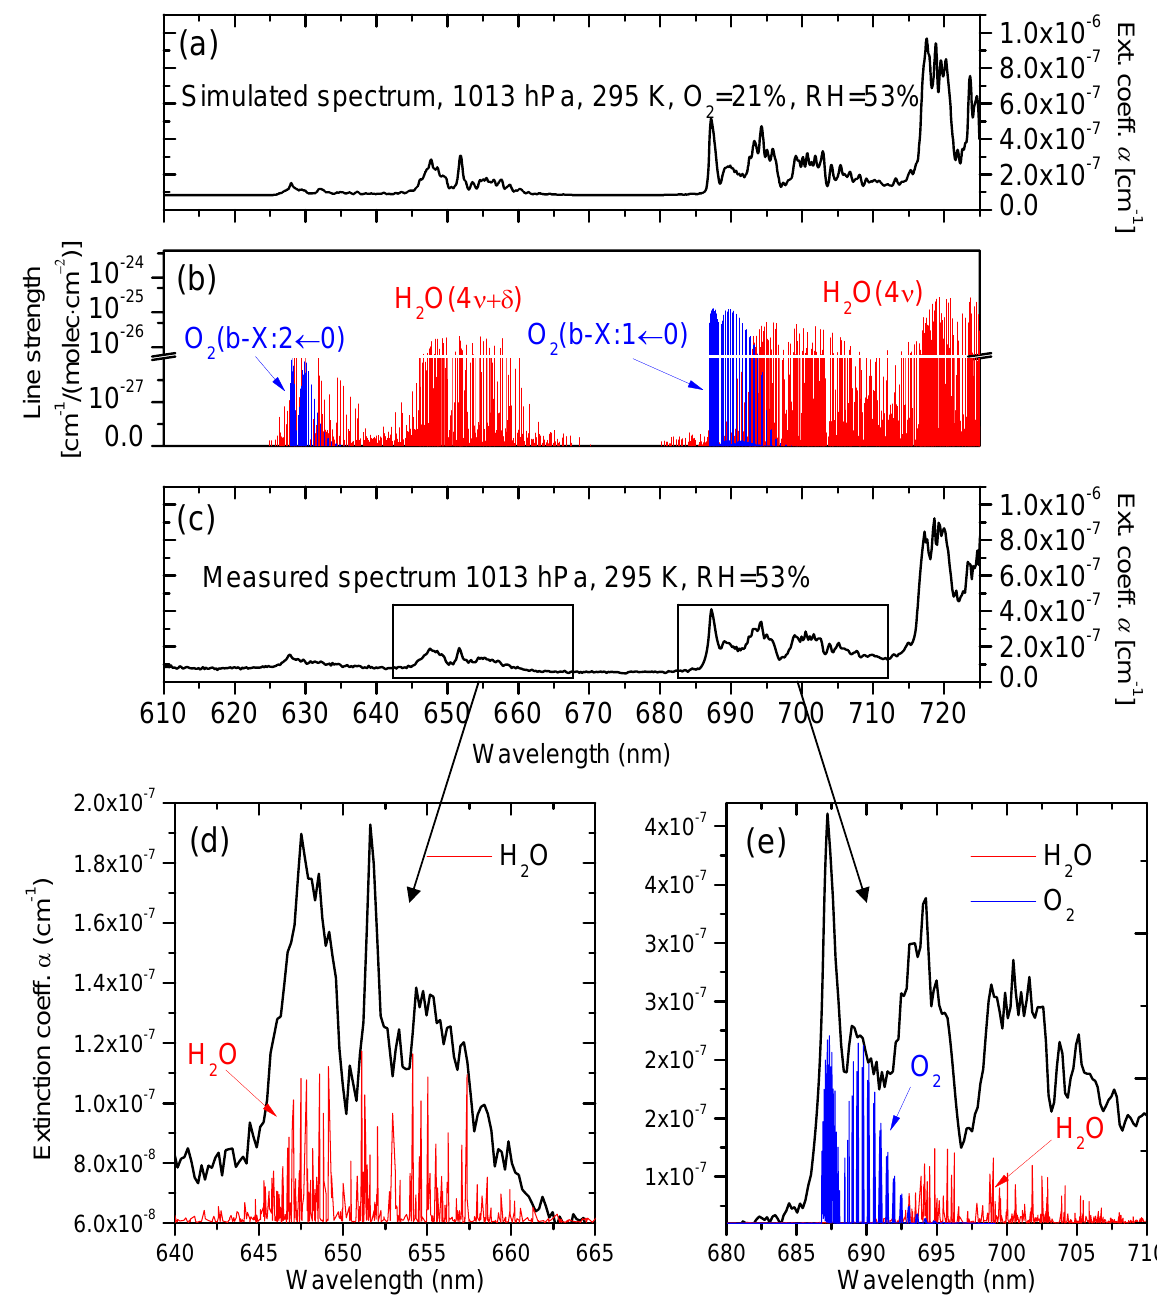
Figure 7. (a) The absorption spectrum of atmospheric air simulated using the Hitran 2000 data base. A background extinction taking into account Rayleigh scattering is added. (b) Line strengths with indicated molecular transitions. (c) The measured spectrum (mirror set 1). (d) and (e) A close-up of selected parts of the